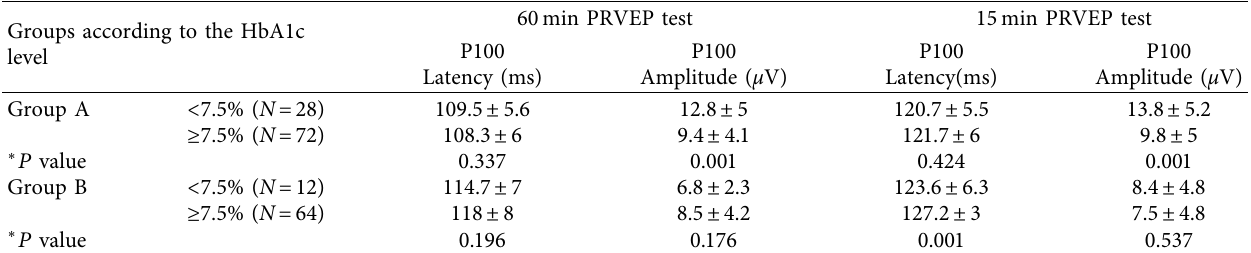
Table 4: The 60min and 15min PRVEP tests parameters in group A and group B according to good glycemic control and poor glycemic control (mean ± SD).